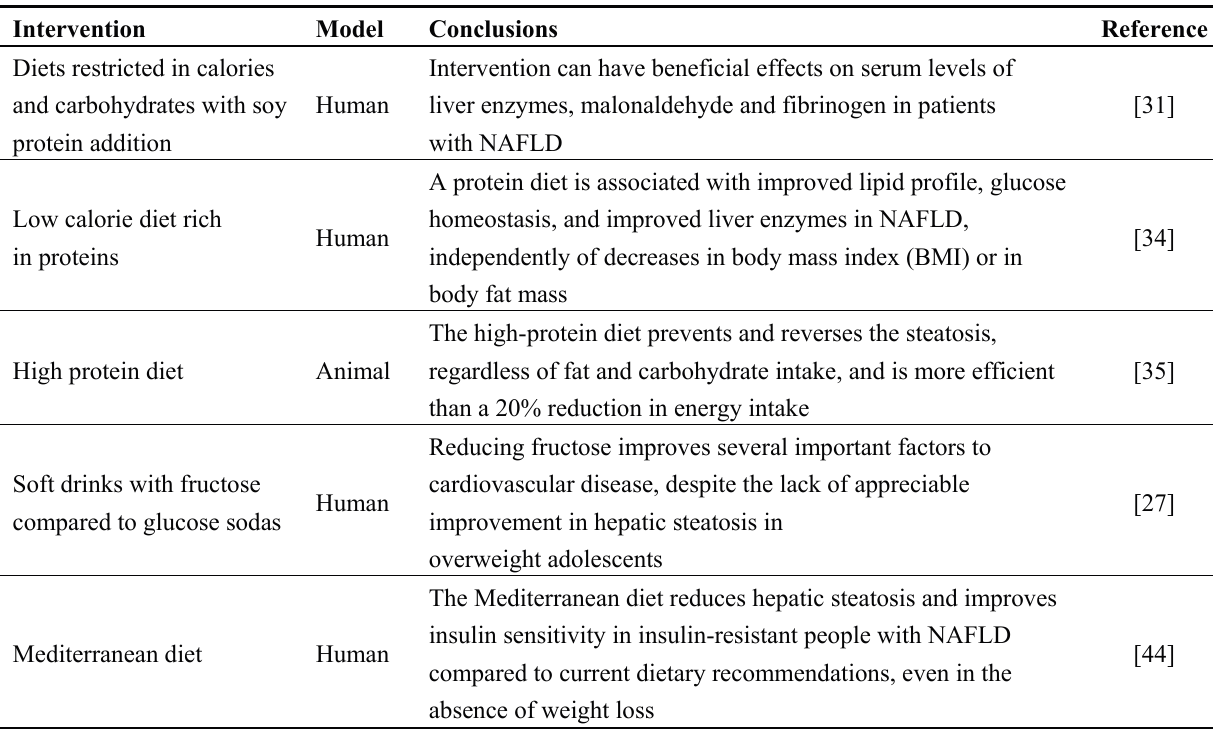
Table 2. Studies on dietary interventions in non-alcoholic fatty liver disease